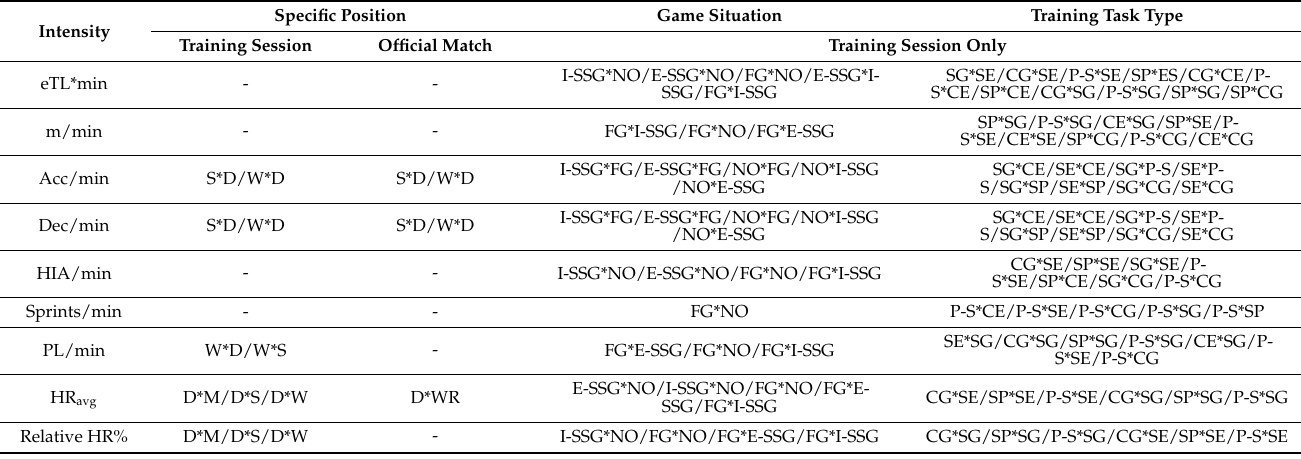
Table 5. Pairwise comparisons according to the intensity